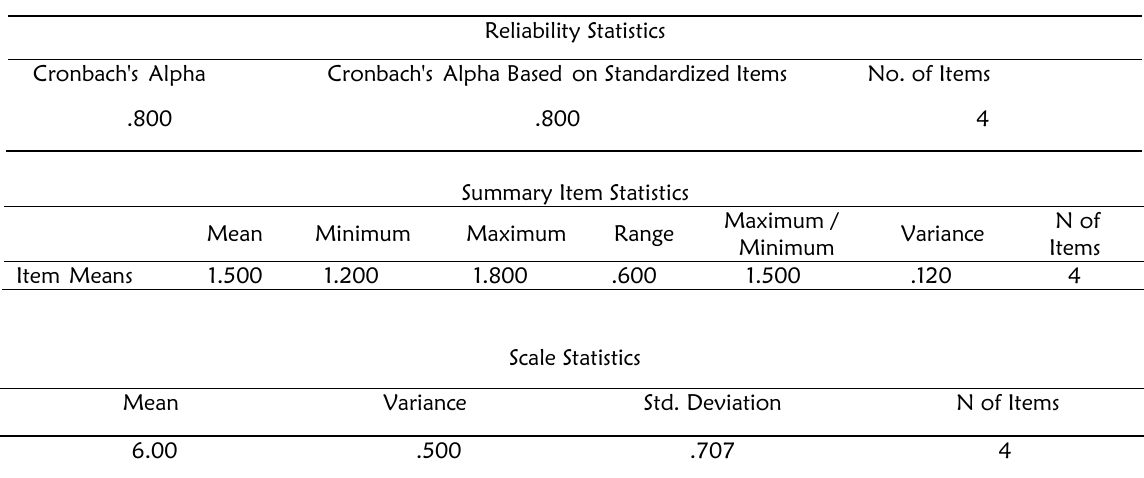
Table 4: Reliability Test on Implementation of Project Management (Section A)